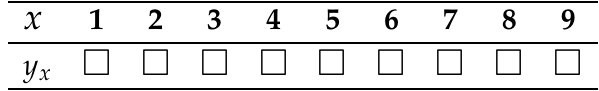
Table 1. Ultimatum game with strategy method: Y ’s decision